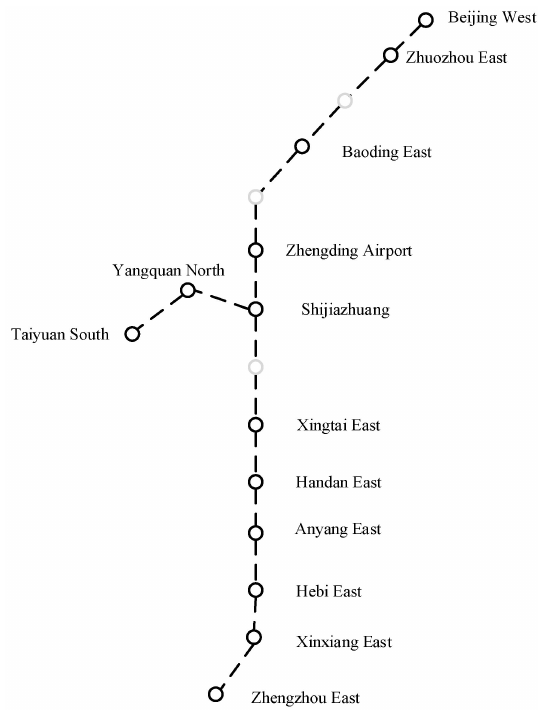
Figure 10. Railway networks of Beijing–Zhengzhou HSR and Beijing–Taiyuan